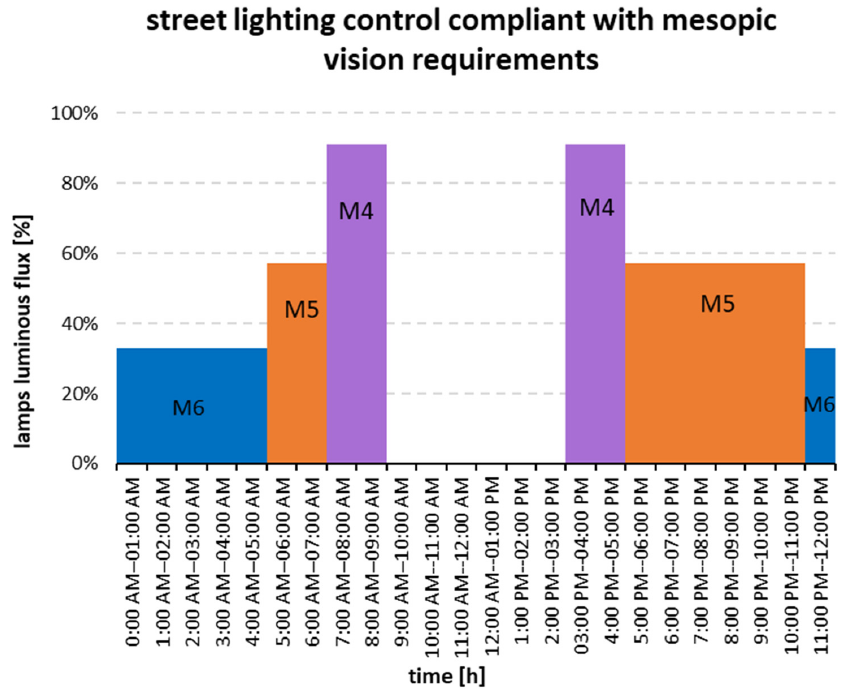
Figure 14. Lighting control profile—case 2 where the control system carries out the control to execute scenario number 2 i.e., adjustment of road luminance levels to the brightness perceived in mesopic conditions.